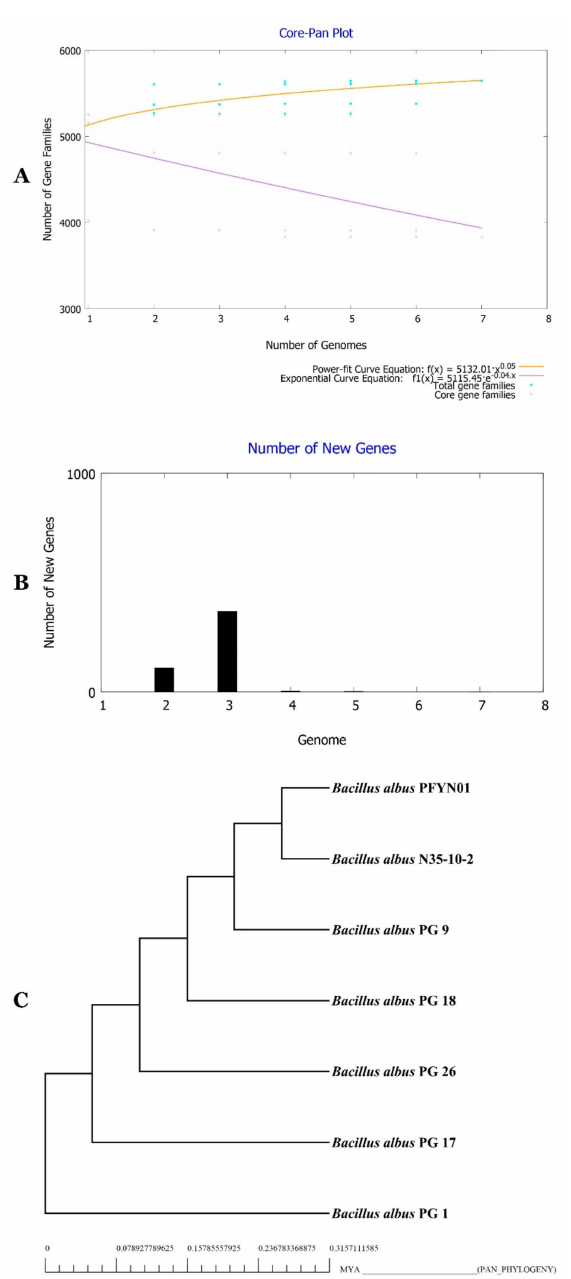
Figure 10. Core-Pan genome plot of BA isolates based on number of genomes and number of gene families ( A ), Number of new genes identified in genomes of BA ( B ), Tree of core-genome phylogeny of BA isolates ( C